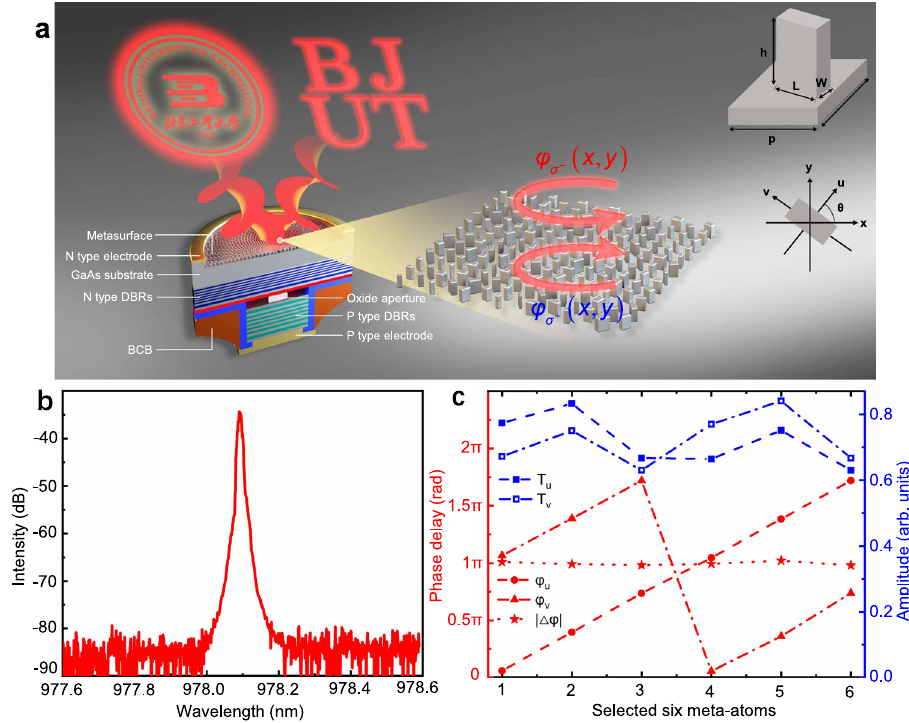
injection current of 4mA at room temperature, which reveal the single funda- mental transverse mode operation. This is achieved by employing a small oxide aperture(~3 µ mindiameter). c Calculatedtransmissionamplitudeandphaseofthe selected six meta-atoms at the wavelength of 978nm. A complete 2 π modulation range of propagation phase ð φ u and φ v Þ is achieved, keeping the phase difference between the two eigen-polarization channels fi xed at: ∣ 4 φ ∣ = ∣ φ u (cid:2) φ v ∣ = π